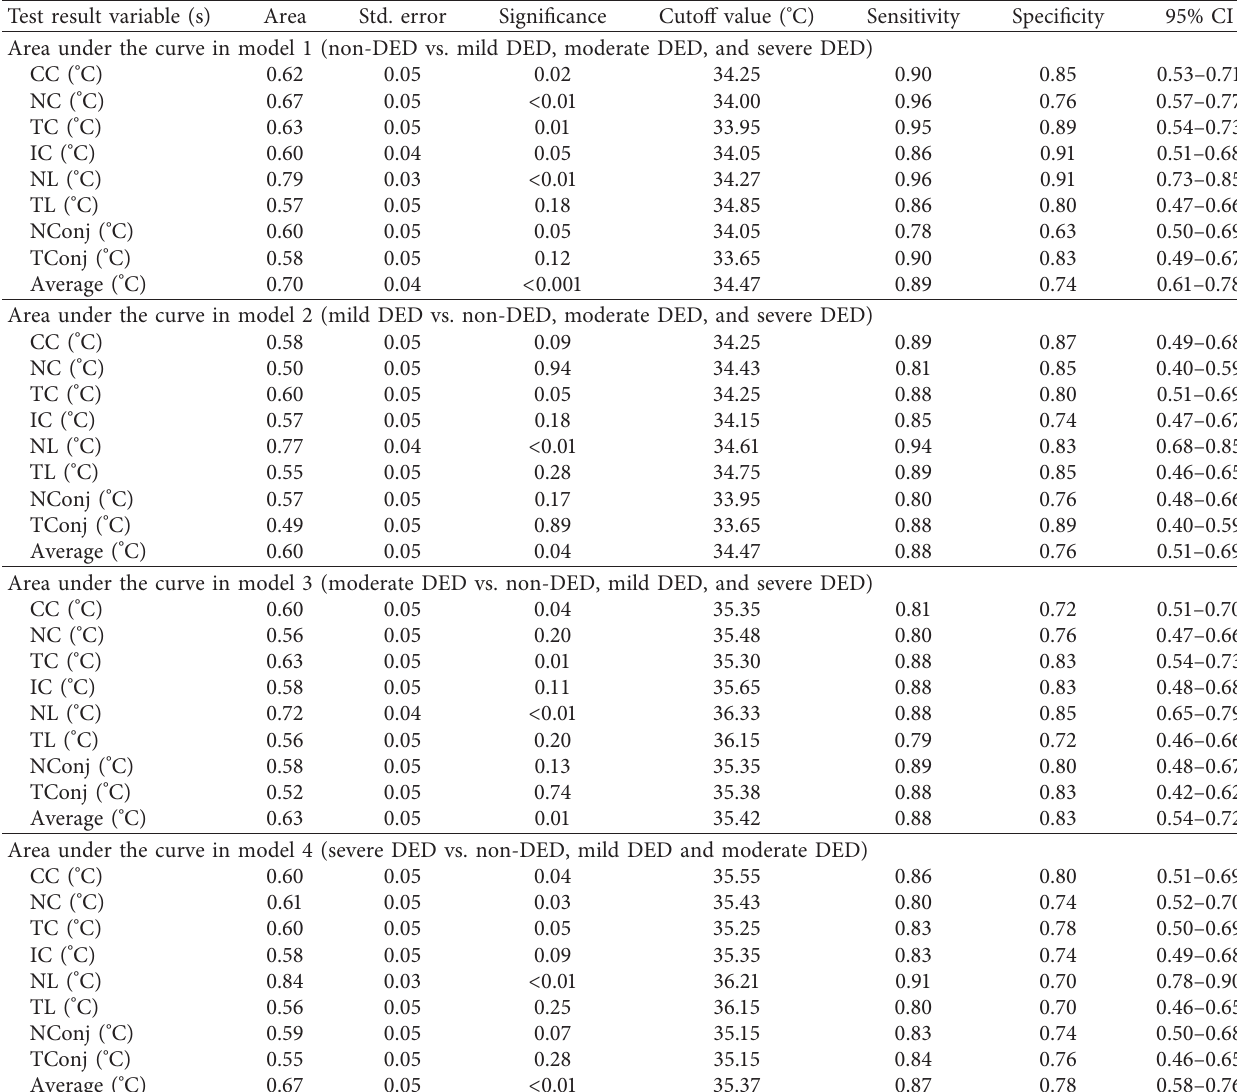
Table 3: Test effectiveness of ocular surface temperature (OST) at various anatomical ROIs (AUC, sensitivity, specificity, and the selected cutoff